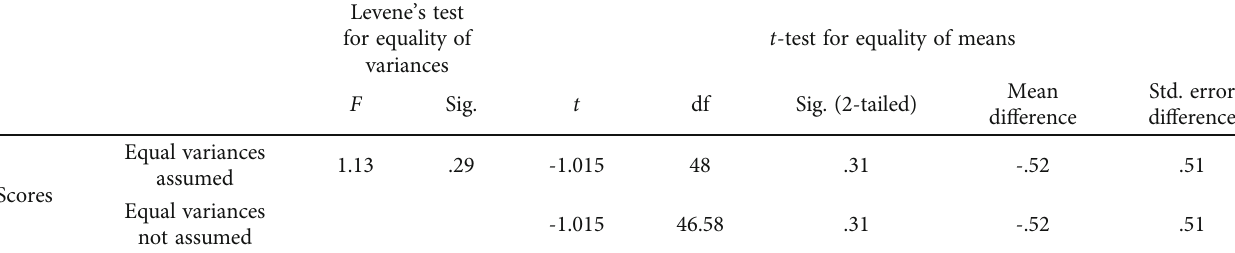
Table 2: Inferential statistics of the grammar pretests.